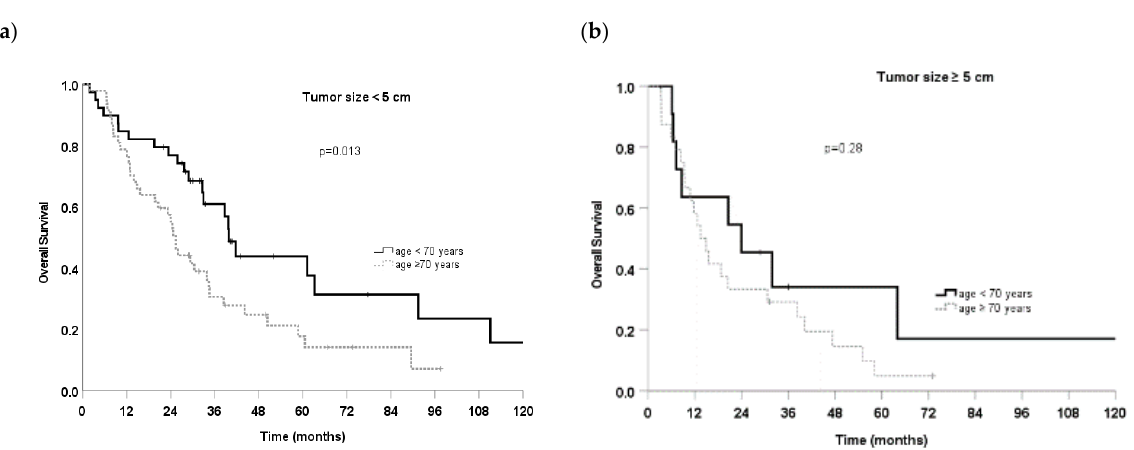
Figure 2. Overall survival for patient with tumor sizes ( a ) < or ≥ 5 cm ( b ) and age< vs. ≥ 70 years.